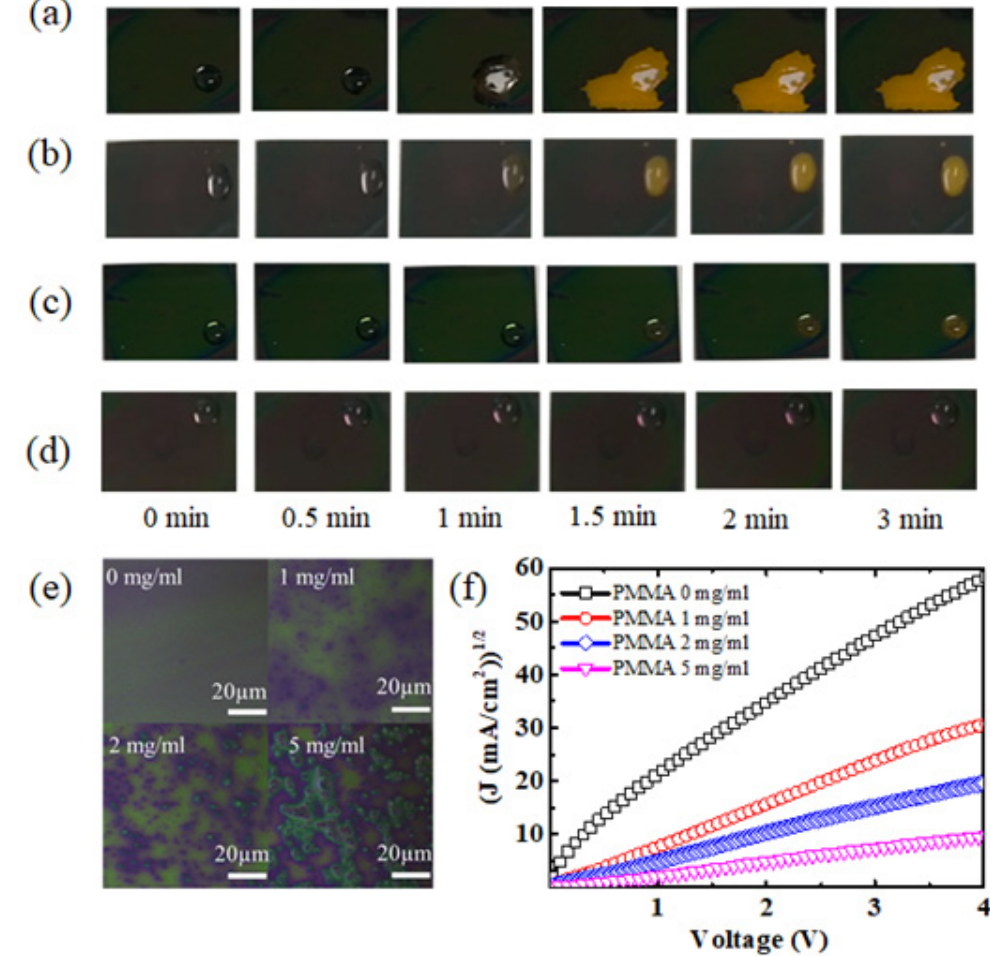
Figure 2. ( a – d ) The surface photographs of samples used in the waterproof test with the PMMA (0 mg/mL, 1 mg/mL, 2 mg/mL, and 5 mg/mL)-doped spiro-OMeTAD HTL observed at regular time intervals from 0 min to 3 min. ( e ) The surface topography and ( f ) hole mobility tests of spiro-OMeTAD HTLs doped with different PMMA concentrations (0 mg/mL, 1 mg/mL, 2 mg/mL, and 5 mg/mL).